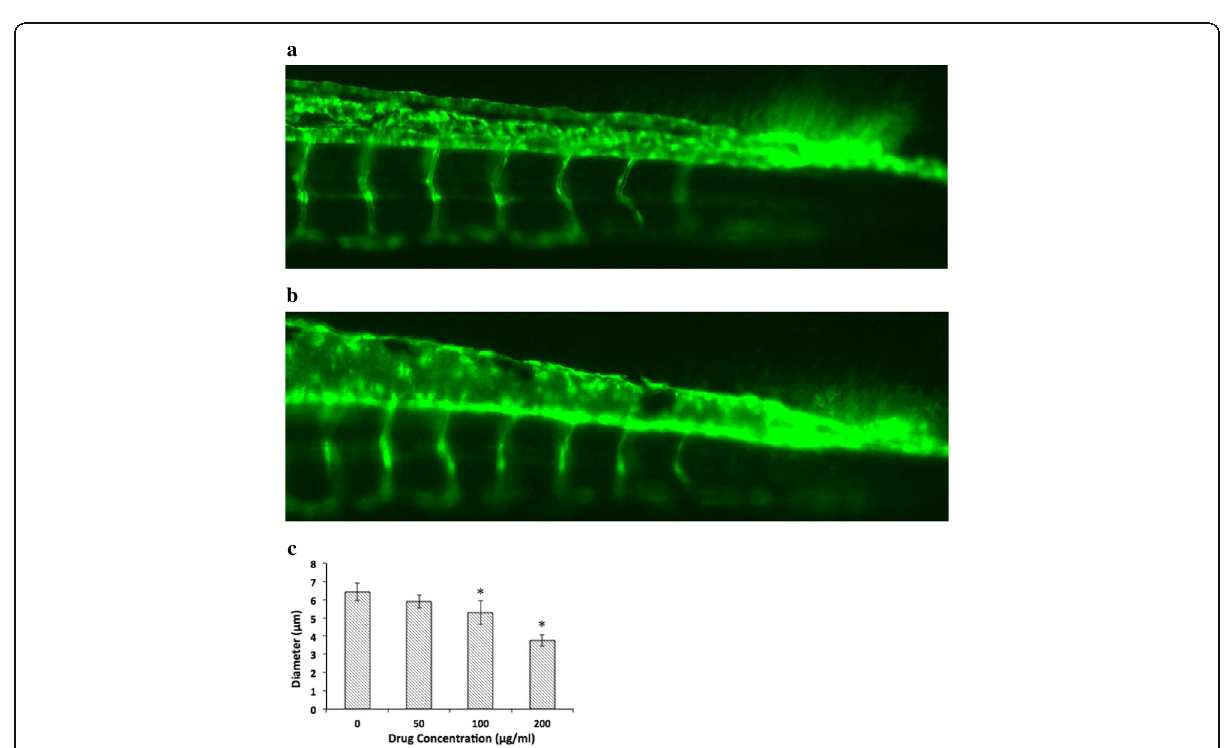
Fig. 6 Antiangiogenic effects of oridonin in the zebrafish embryos. The average diameters of three blood vessels from the end of the tail were measured and calculated. a control group; b 200 μ g/ml oridonin group; c Diameter length comparison. The asterisks indicate statistically significant differences from the control group (* P <